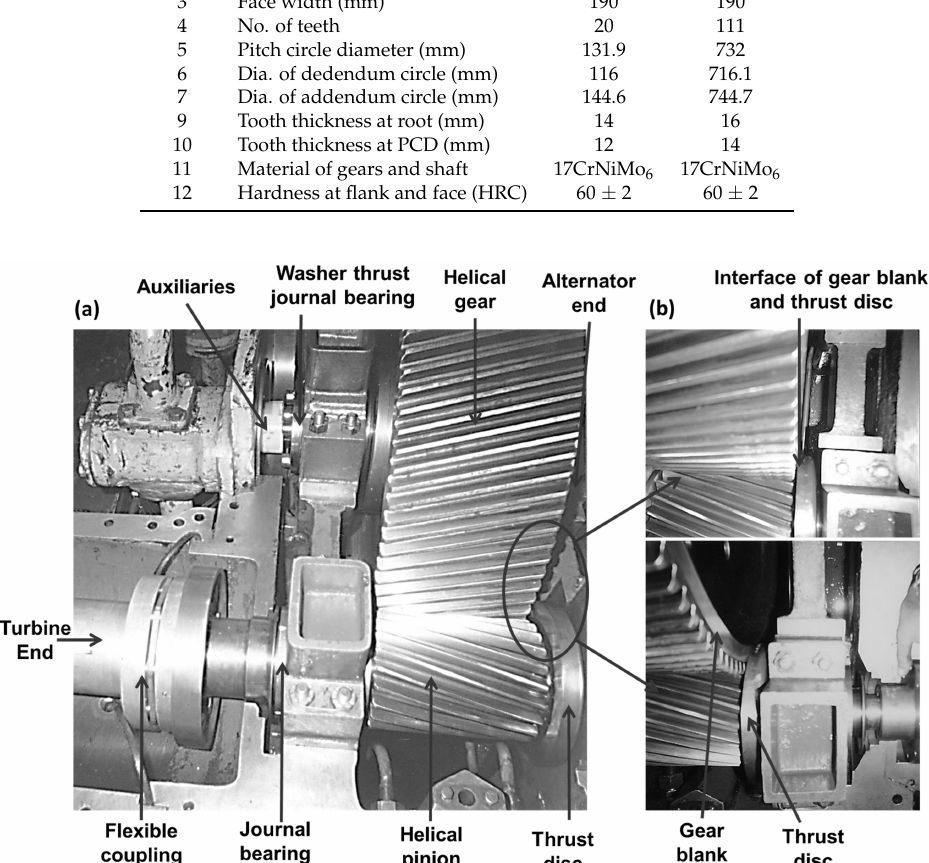
Figure 1. ( a ) Photographic view of helical gearbox with names of vital components; ( b ) photographic view of pinion’s axial thrust sustaining arrangement.